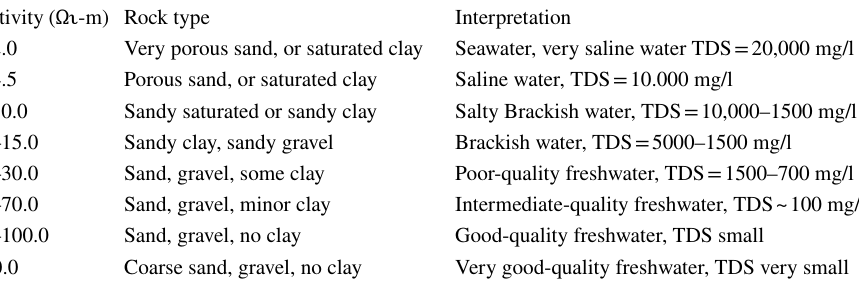
Table 2 Resistivity values for water and sediment